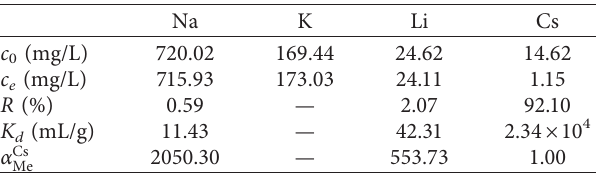
Figure 6: Effect of pH value on adsorption capacity (a). Influence of contact time on Cs + adsorption (b). Nonlinear fitting diagrams of the adsorption kinetic model (c) ( c 0 � 110mg/L, m/V � 0.5 g/L, T � 298K). Effects of initial concentration on Cs + adsorption (d). Linear fitting diagram of Langmuir (e) and Freundlich (f) isotherm models ( c 0 � 60–1300mg/L, m / V � 0.5g/L, t � 0.5h). Table 1: The selectivity parameters of Cs + against the coexisted